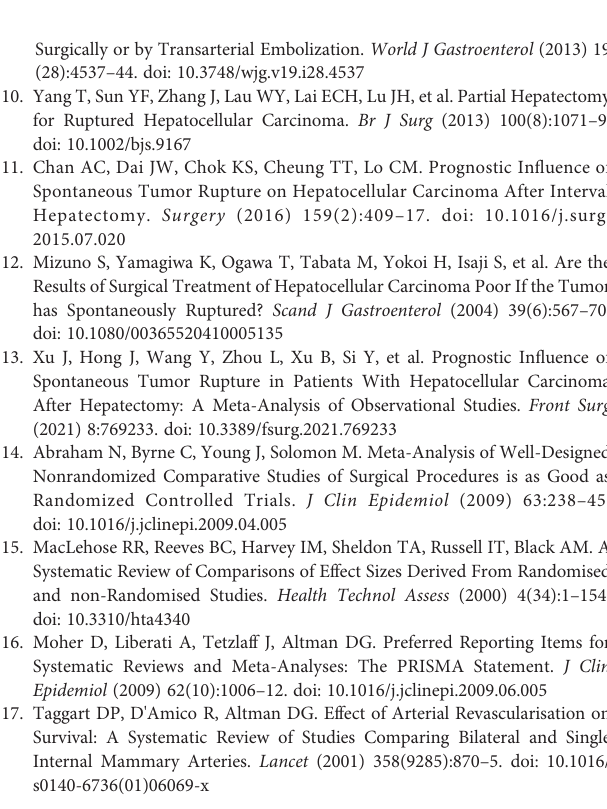
Supplementary Figure 1 | Forest plots for population characteristics of the included studies. Meta-analysis using the fi xed effects model found no signi fi cant difference between rHCC and nrHCC groups in (A) sex ratio (OR, 1.27, 95%CI: 0.80 – 2.04, P = 0.31, I 2 = 0), (B) age (WMD, -0.62, 95%CI: -1.96 – 0.72, P = 0.37, I 2 = 0), (C) rate of liver cirrhosis (OR, 0.98, 95%CI: 0.64 – 1.50, P = 0.92, I 2 = 0) and (D) rate of Child-Pugh classi fi cation A (OR, 0.71, 95%CI: 0.39 – 1.31, P = 0.27, I 2 = 0). Supplementary Figure 2 | Forest plots for population characteristics of the included studies. Meta-analysis using the fi xed effects model found no signi fi cant difference between rHCC and nrHCC groups in (A) rate of macrovascular invasion (OR, 1.10, 95%CI: 0.73 – 1.66, P = 0.65, I 2 = 0), (B) rate of microvascular invasion (OR, 1.22, 95%CI: 0.84 – 1.79, P = 0.30, I 2 = 0), (C) rate of solitary nodule (OR, -0.04,95%CI:-0.12 – 0.04, P =0.31, I 2 =30%)and (D) tumorsize(WMD,0.22,95% CI: -0.43 – 0.86, P = 0.51, I 2 =